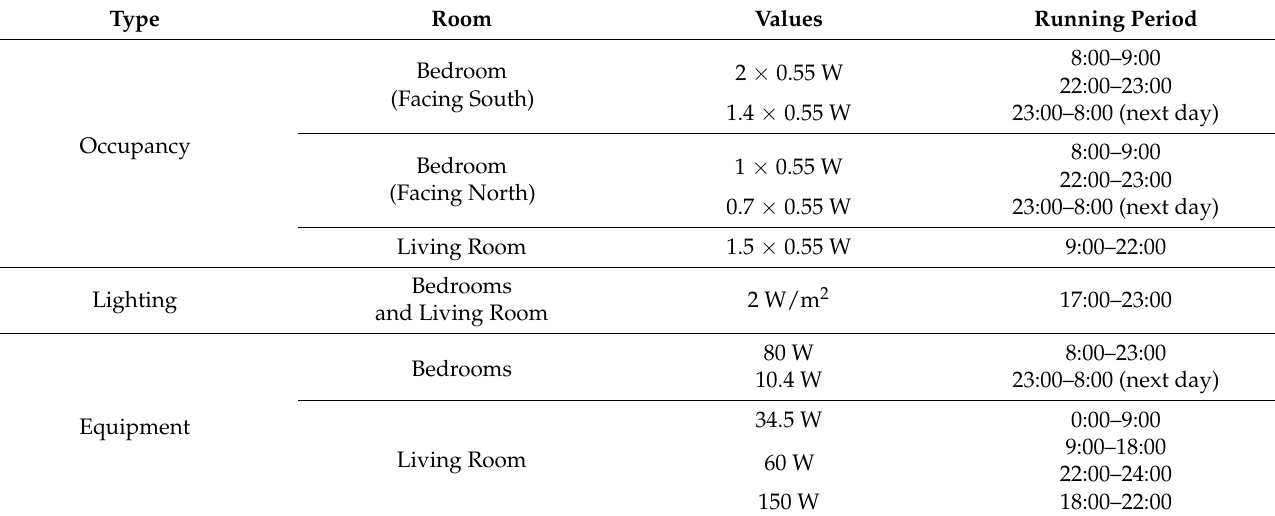
Table 8. Internal gain settings in the